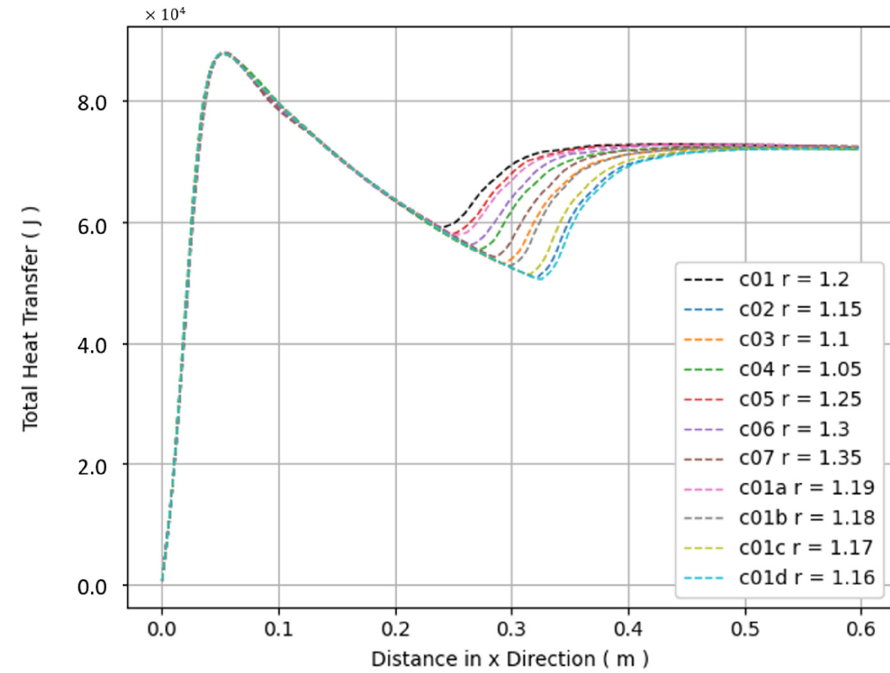
Figure 4. Grid convergence study of growth ratio ‘r’.